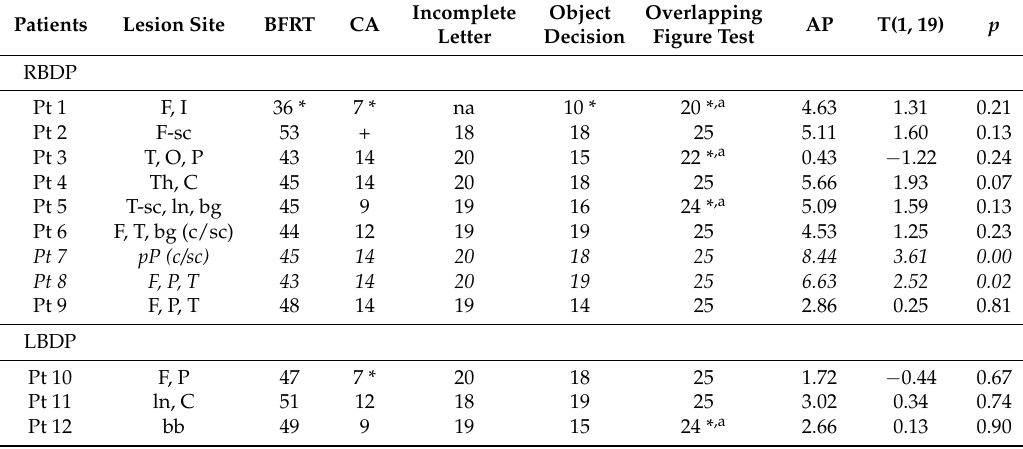
Table 3. For each patient the lesion site, the performances at visuo-constructional and visuo-perceptual tests, the mean rating on the VAS on AP, and the results of the Crawford’s analysis are reported. Patients who showed significant difference on AP are reported in italics. Notes. * deficit; na, not applicable; a Cut-off of the Overlapping figure test is 1 error, because none of the Cs make any error. F = frontal lobe; O = occipital lobe; P = parietal lobe; T = temporal lobe; I = insula; c = cortical; sc = subcortical; th = thalamus; C = capsula; iC = internal capsula; ln = lenticular nucleus; bg = basal ganglia; p = posterior; a = anterior; bb = bulbo; crb = cerebellum; HC = hippocampus; paI = parainsular cortex; cr = corona radiate; cp = cerebral